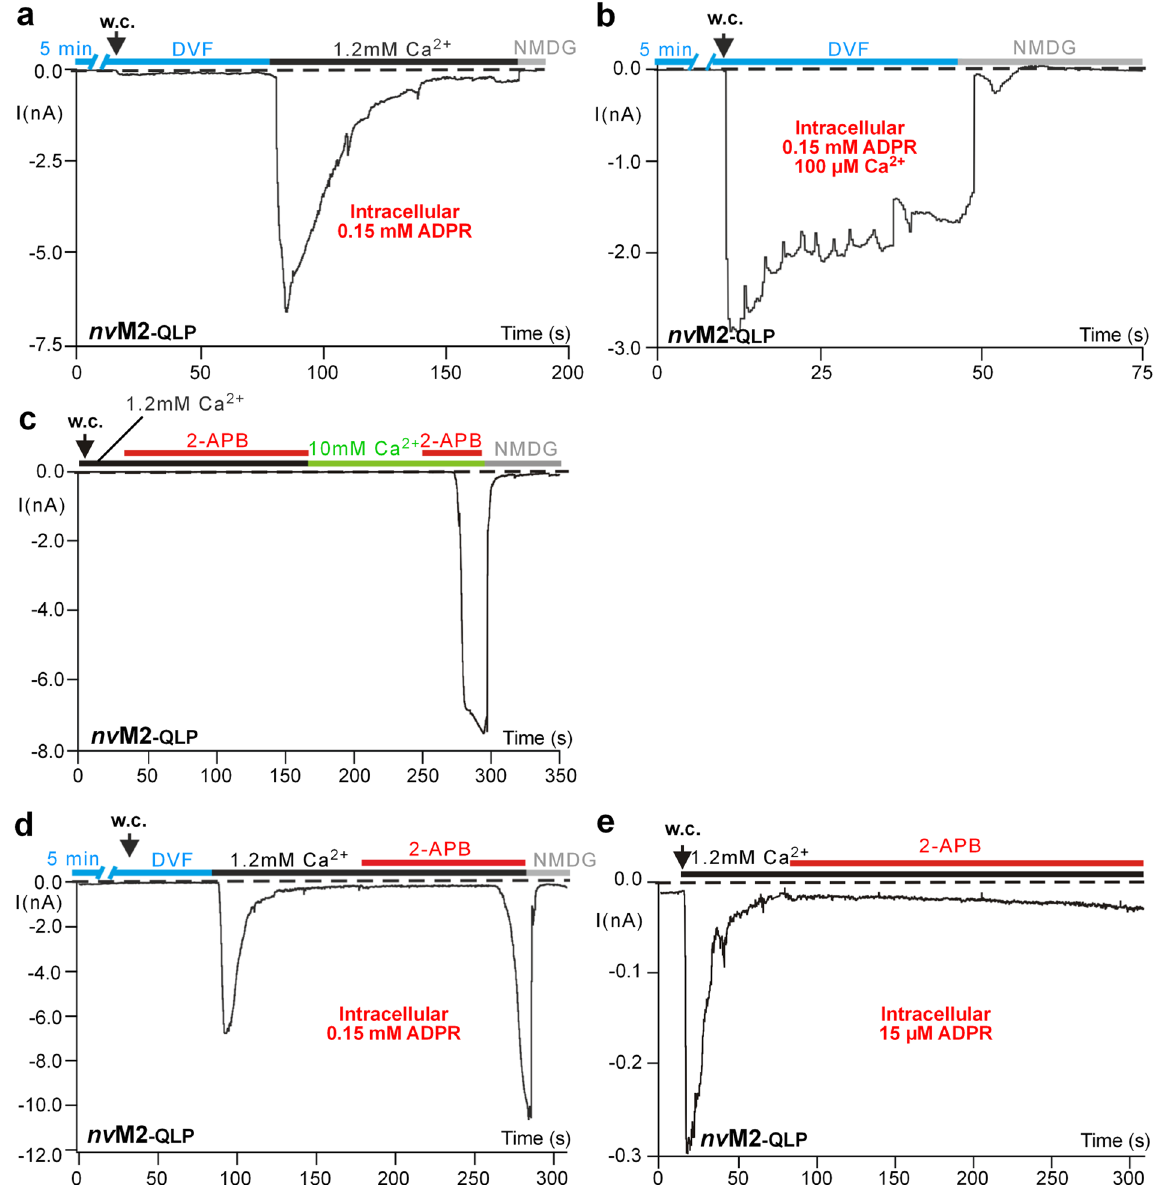
Figure 5. Diminished effects of ADPR and 2-APB in the QLP variant of nv TRPM2, restored by elevated Ca 2 + . ( a ) ADPR requires extracellular Ca 2 + in nv TRPM2-QLP in the presence of standard intracellular Ca 2 + concentrations. With ADPR (0.15 mM) and Ca 2 + (1 µ M) in the pipette solution, current recording was started after extended exposure to DVF. Restoration of standard extracellular Ca 2 + (1.2 mM) enabled normal currents that were missing without extracellular Ca 2 + . ( b ) ADPR becomes effective on nv TRPM2-QLP under extracellular divalent-free conditions when intracellular concentrations of Ca 2 + are strongly increased. Stimulation was performed with ADPR (0.15 mM) and strongly elevated Ca 2 + (100 µ M) in the pipette solution. Note the decelerated inactivation. ( c ) 2-APB becomes effective in strongly increased concentrations of extracellular Ca 2 + in nv TRPM2-QLP. Two stimulations were performed with 2-APB (1 mM), first in the presence of a standard extracellular Ca 2 + (1.2 mM) and then at high Ca 2 + (10 mM). The pipette solution contained Ca 2 + (1 µ M) but no ADPR. ( d ) 2-APB becomes effective in standard extracellular Ca 2 + (1.2 mM) after pre-stimulation with ADPR. The experiment was started with exactly the same protocol as in panel a, followed by a stimulation with 2-APB (1 mM) that this time did induce currents. Note the long lag time as well as the difference in amplitudes between the two stimulations. 2-APB (1 mM) consistently evoked larger currents than ADPR (0.15 mM) alone. ( e ) Pre-stimulation with low concentrations of ADPR is not sufficient to enable 2-APB effects. With only 15 µ M instead of 0.15 mM ADPR in the pipette, small currents were induced but subsequent application of 2-APB (1 mM) failed to evoke the same strong currents as shown in panel c. All experiments were repeated at least three times confirming the